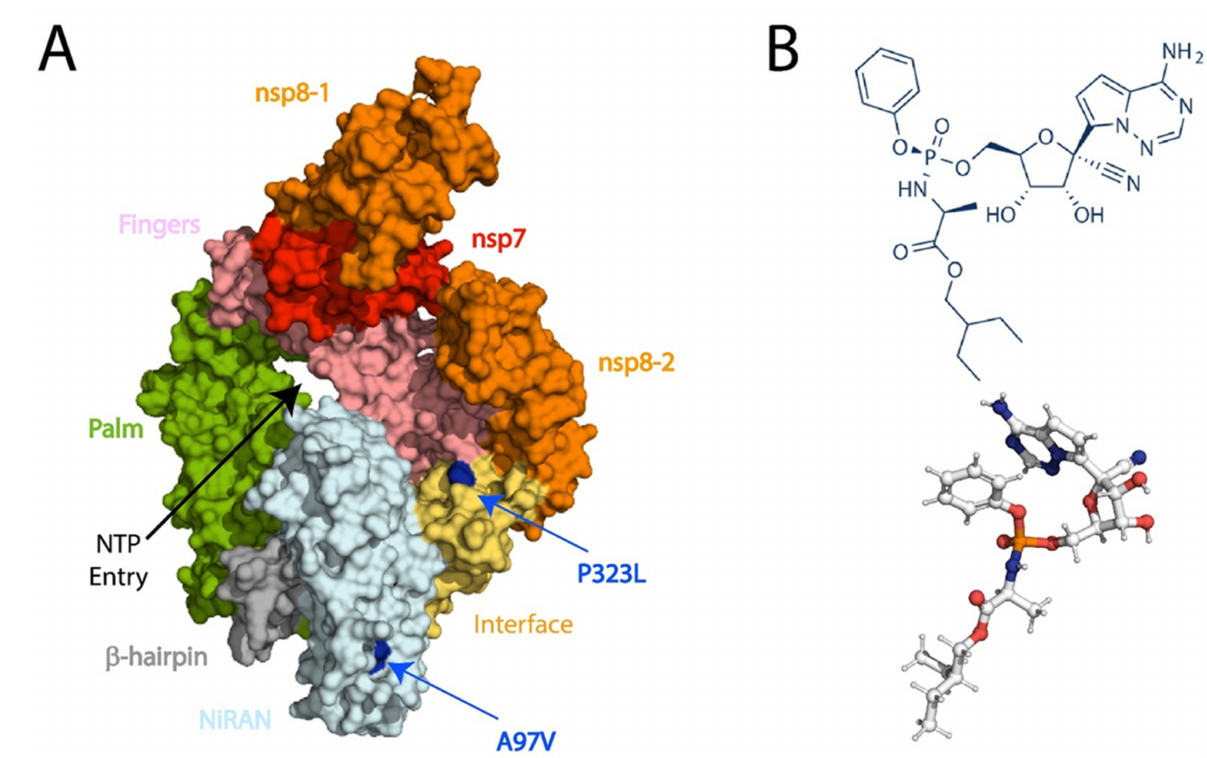
Figure 1. (The structure RdRp (PDB ID: 7BV2) [22]. ( A ) Viral RNA template entry and the NTP entries are shown with black arrowheads, the route for the release of RNA template and product after replication are shown with a black arrow and two dashed black arrows. The NiRAN, b-hairpin, palm fingers, and interface are part of nsp12, nsp8 is depicted in orange and nsp7 in red. The A97V and P332L mutations are depicted in blue. ( B ) Chemical structure and 3D conformer of Remdesivir (RDV).